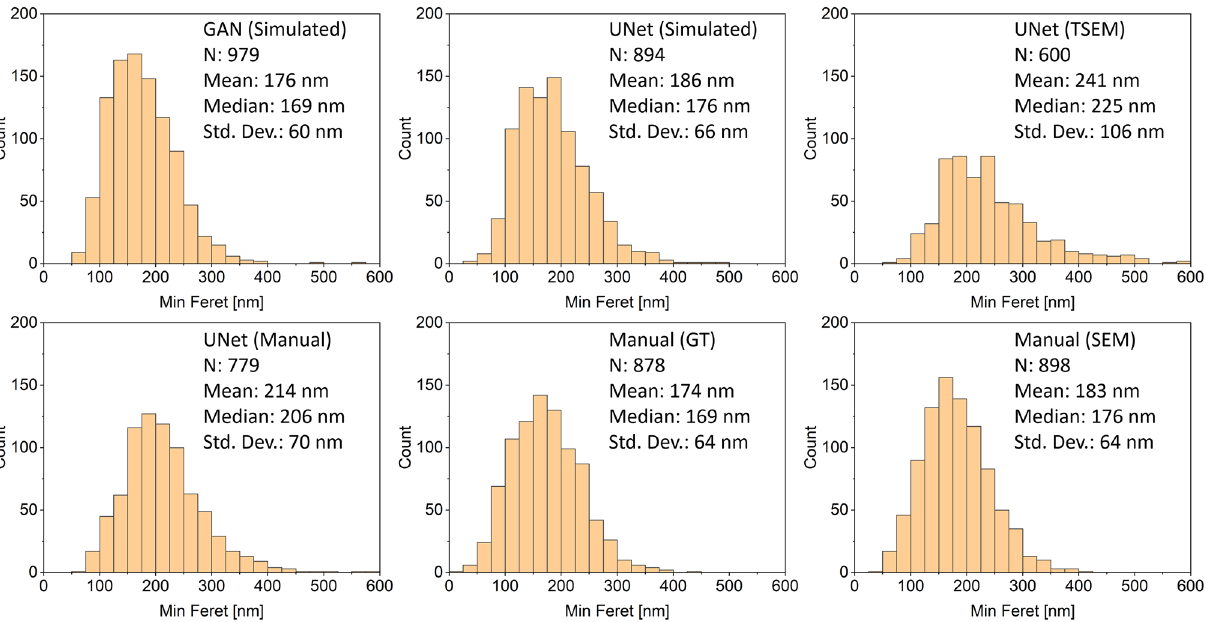
Figure 3. Size histograms (minimum Feret diameter) obtained with the methods mentioned in the text and in Table S1 (Supporting Information) for agglomerated titania